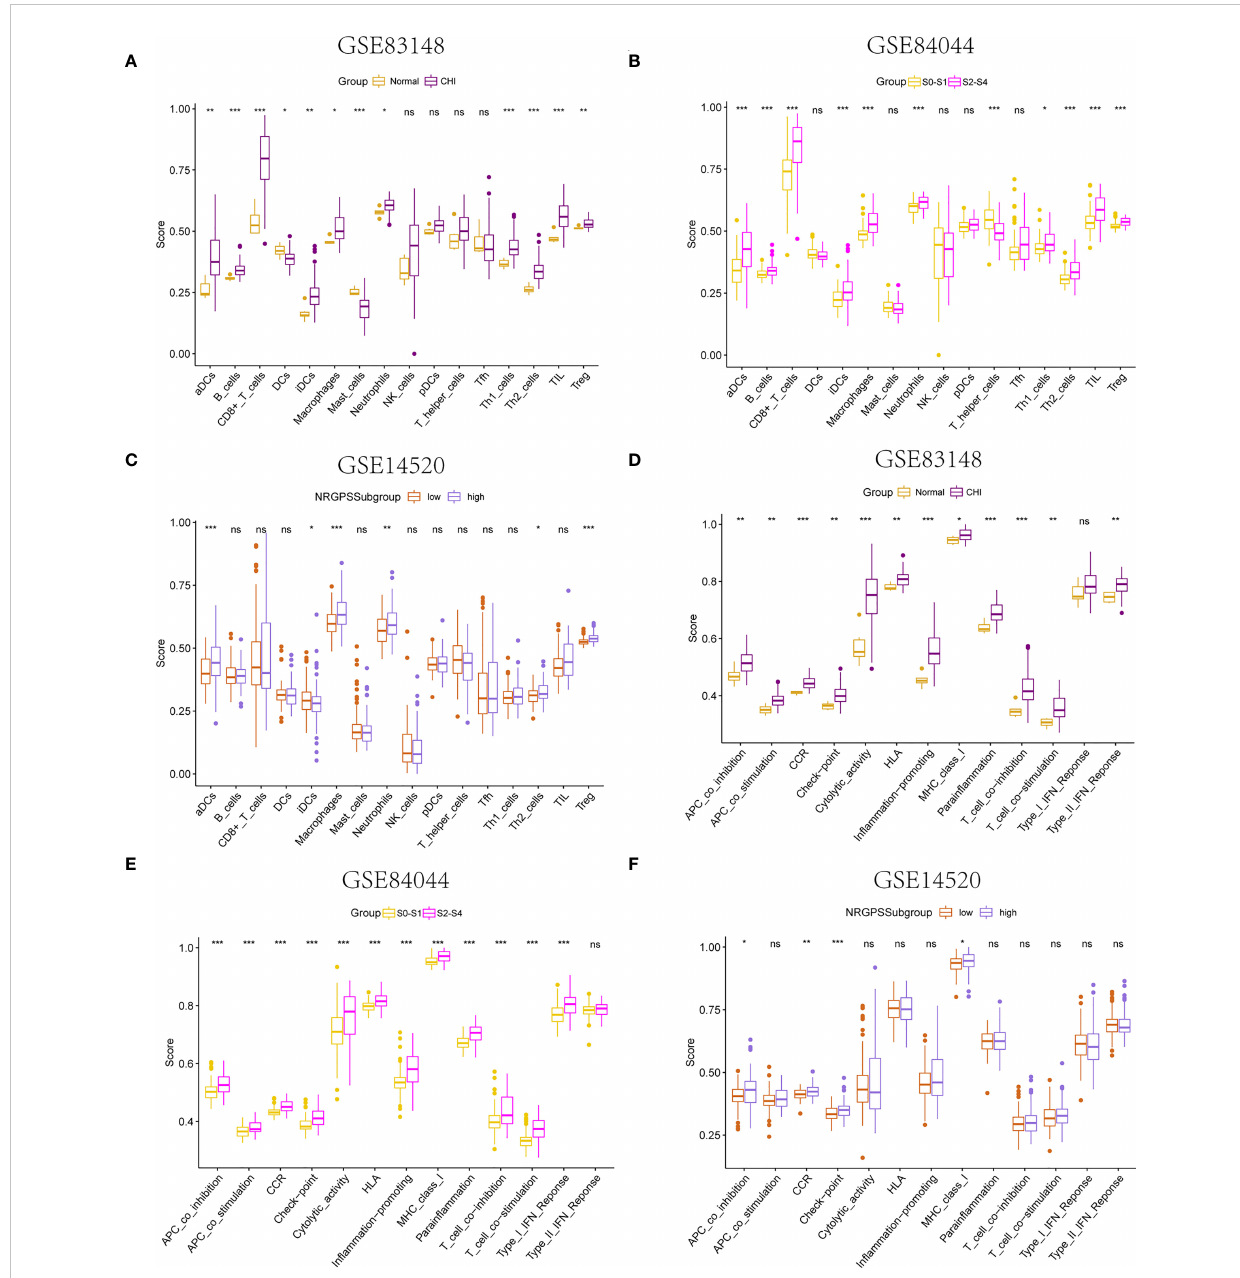
FIGURE 7 Immune microenvironment analysis. The boxplot of 16 immune cell differences in (A) GSE83148, (B) GSE84044, (C) GSE14520. The boxplot of 13 immune signaling pathway differences in (D) GSE83148, (E) GSE84044, (F) GSE14520. * P <0.05, ** P <0.01, *** P < 0.001, ns, not signi fi